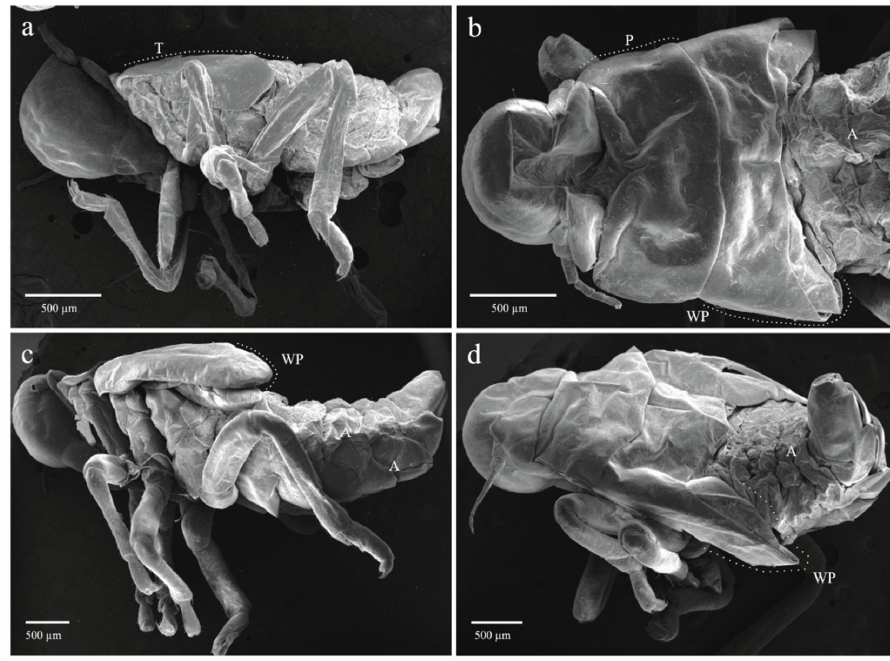
Figure 7. Immature stages of Ocoaxo assimilis showing di ff erent degrees of development of wing pads. a ) Nymphal instar one (NI) in lateral view, b ) nymphal instar three (NIII) in dorsal view, c ) nymphal instar four (NIV) in lateral view, d ) nymphal instar five “a” (NVa) in posterior-dorsal view. A (abdomen), P (pronotum), WP (wing